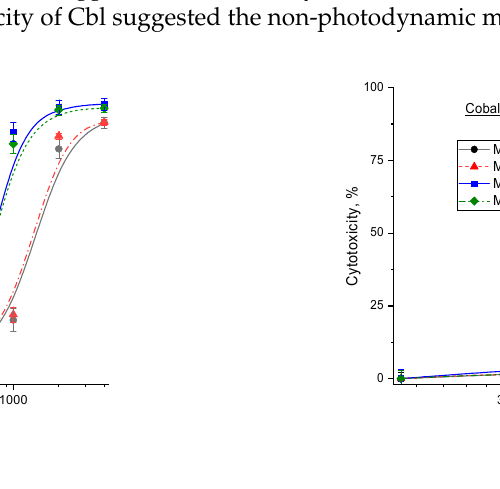
( b ) Figure 4. Dark and photo-cytotoxicity of zinc(II) phthalocyanines differing in the position of substi- tution groups ((3ZnPc and 4ZnPc) presented as followed: ( a ) 3ZnPc and ( b ) 4ZnPc on two breast tumor cell lines (MCF-7 and MDA-MB-231) and a non-tumorigenic MCF-10A cell line. The addition of a second compound, such as Cbl, showed a tendency to minimize the high dark toxicity of 3ZnPc due to lower concentrations for the similar efficiency (Figure 5). An improvement to the selectivity between tumor normal cells was observed for the mixture of 3ZnPc and Cbl. As can be seen, 3ZnPc showed complete cell death for concen- trations <0.1 μ M at the irradiation only with LED 660 nm (100 mW/cm 2 and 50 J/cm 2 ). The calculated results for 3ZnPc are summarized in Table 1. They showed that the addition of a biologically active compound, such as Cbl, increased the photodynamic effect (PI) of 3ZnPc for lower concentrations. Moreover, the highest efficiency of the combined appli- cation of compounds Cbl and 3ZnPc was observed for the more aggressive MDA-MB-231